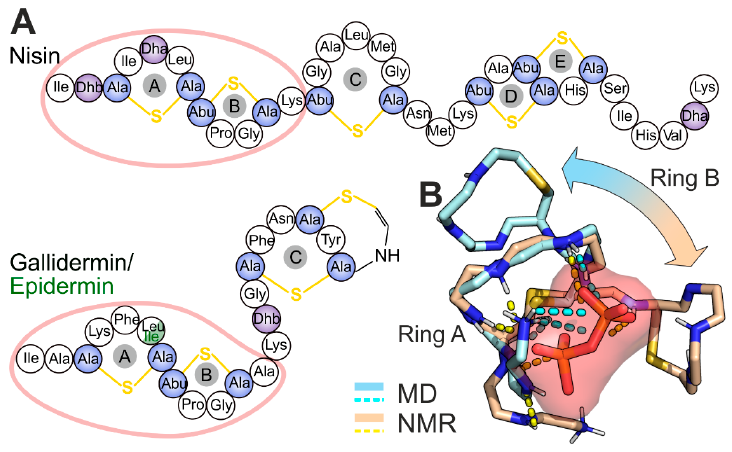
Figure 1. Structures of nisin, epidermin, gallidermin, and nisin/lipid II complexes in water and DMSO. ( A ) Schematic chemical structure of nisin, epidermin, and gallidermin. Modified amino